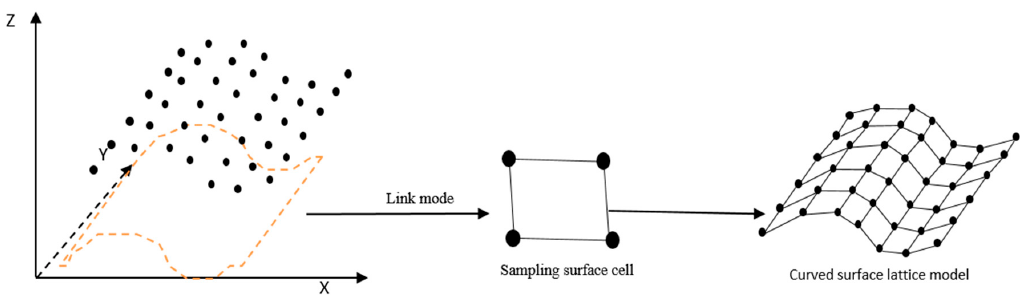
Figure 5. Spatial lattice model for curved surface space.